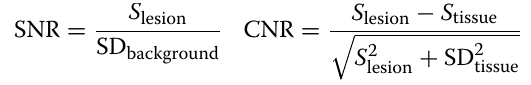
tial fitting algorithm on 1.5 T MRI console without